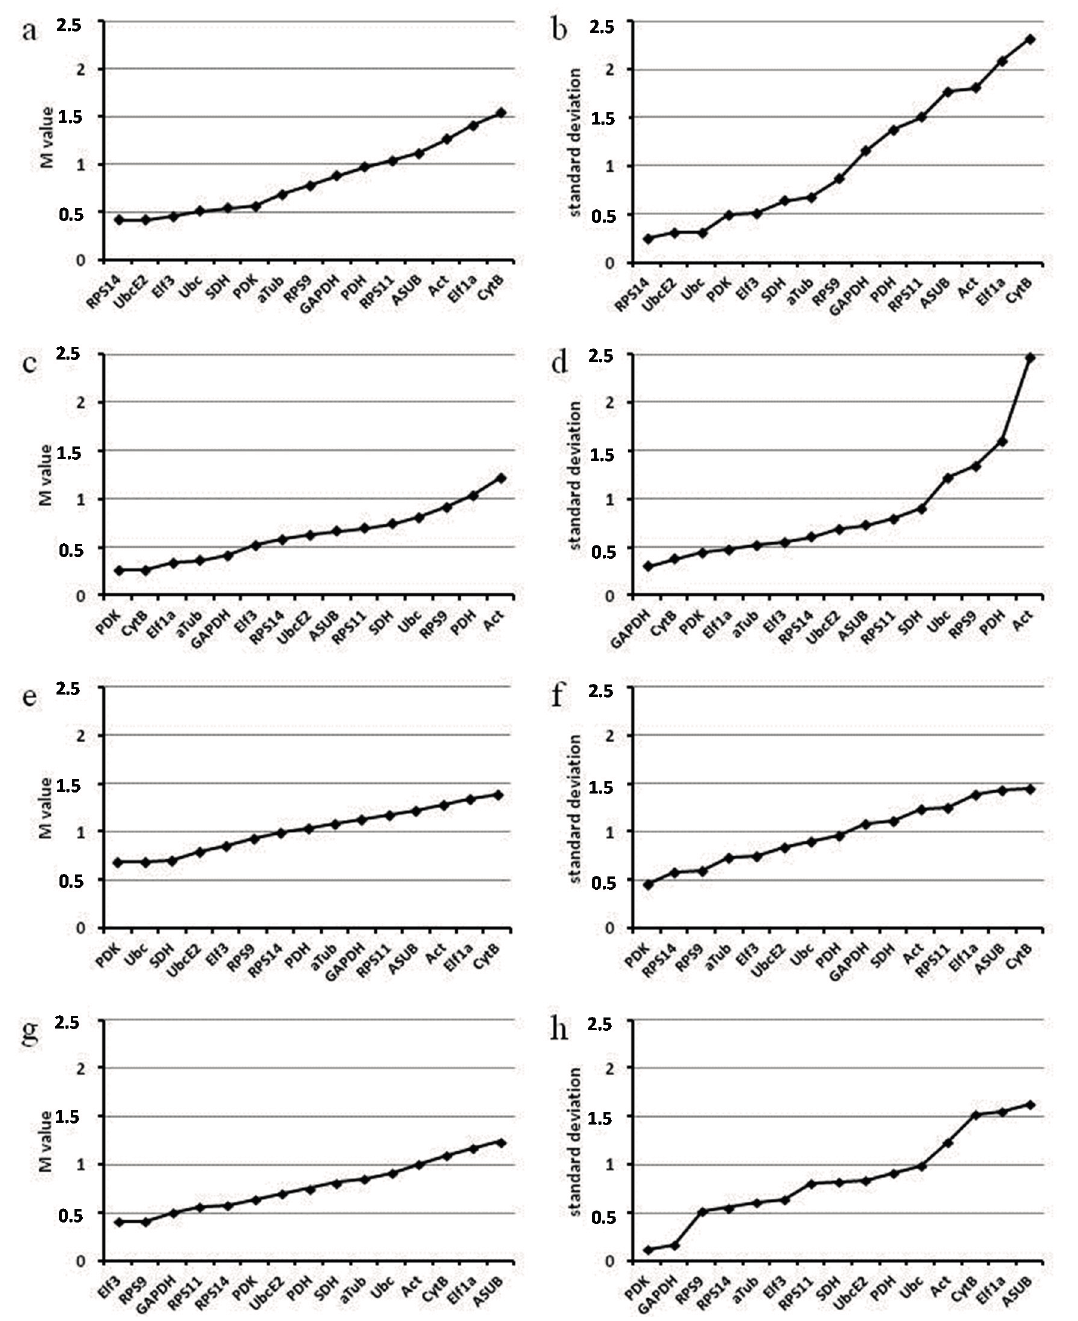
Figure 2. Ranking of P. pachyrhizi candidate reference genes for stability by the algorithms geNorm ( a , c , e , g ) and NormFinder ( b , d , f , h ). Analyses performed for ( a , b ) in vitro samples; ( c , d ) in planta samples; ( e , f ) all samples; ( g , h ) in planta samples together with germ tube (gt) sample; M-value: gene-stability measure calculated by geNorm—the arithmetic mean of all pairwise variations of the respective gene against all other genes between the different samples; standard deviation (here): stability measure calculated by NormFinder based on group wise